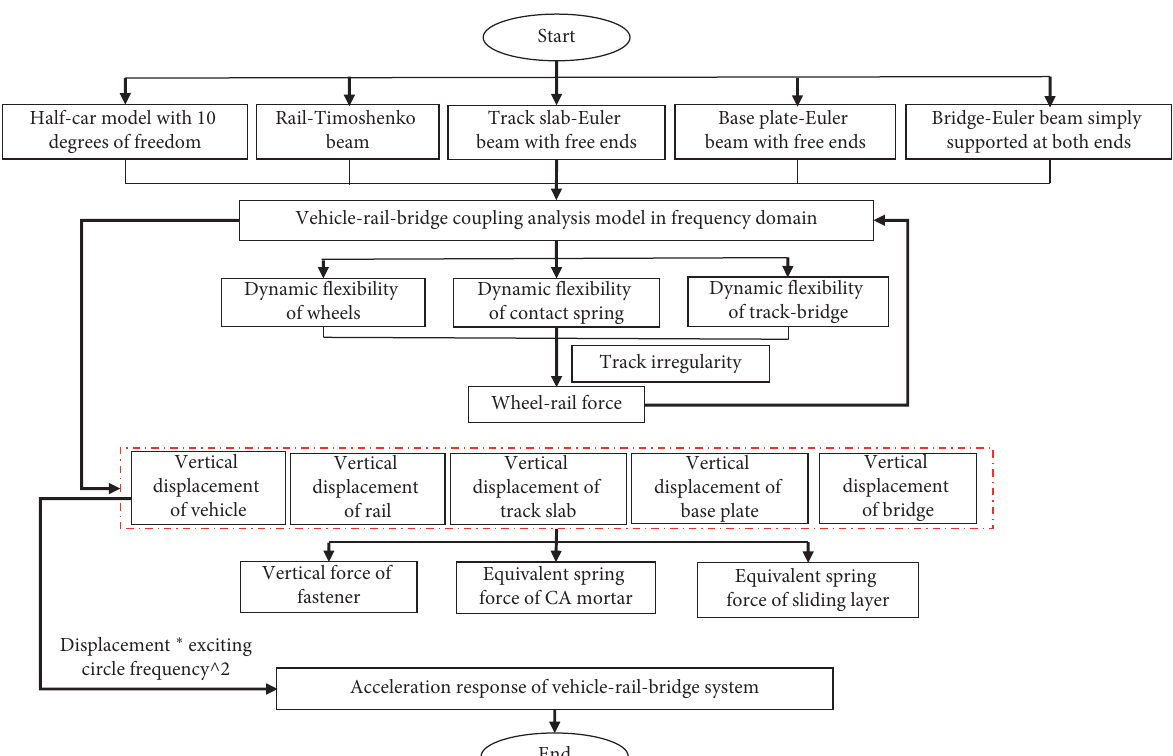
Figure 3: Calculation flow